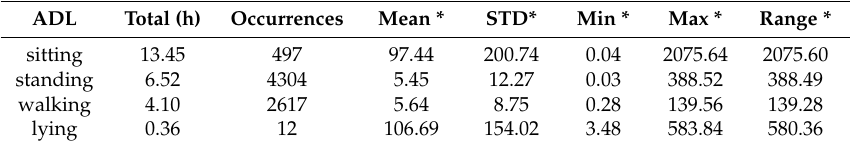
Table 3. Out-out-lab ADLs.